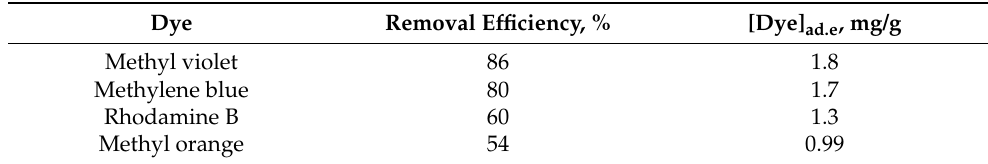
Table 6. Adsorption of dyes by